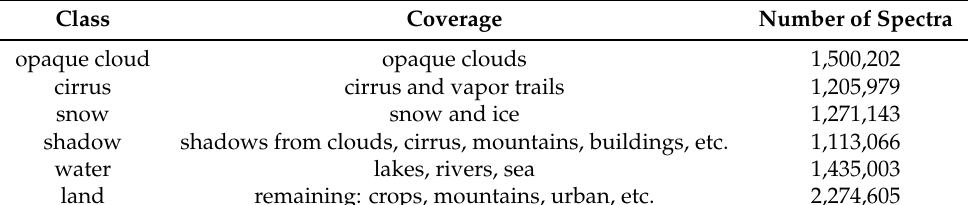
Table 2. Spectra comprising the training set.